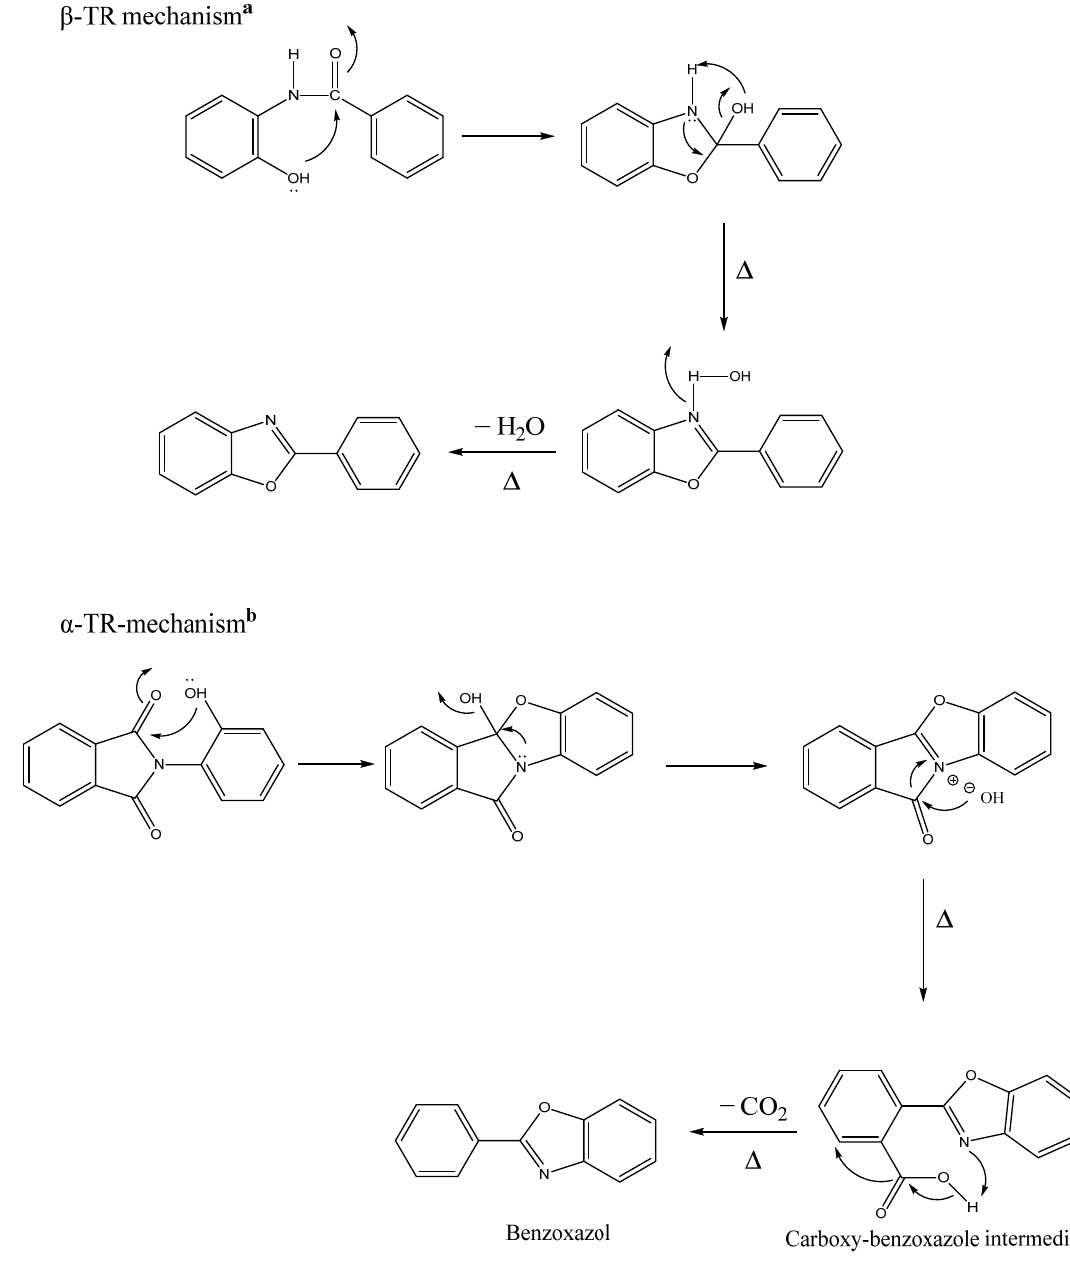
Figure 13. Mechanism of thermal conversion of a cyclodehydration of a hydroxypoliamide to polybenzoxazole ( β‒ TR ‒ PBO) a and thermal conversion of a hydroxypolyimide to polybenzoxazole ( α‒ TR ‒ PBO) b .